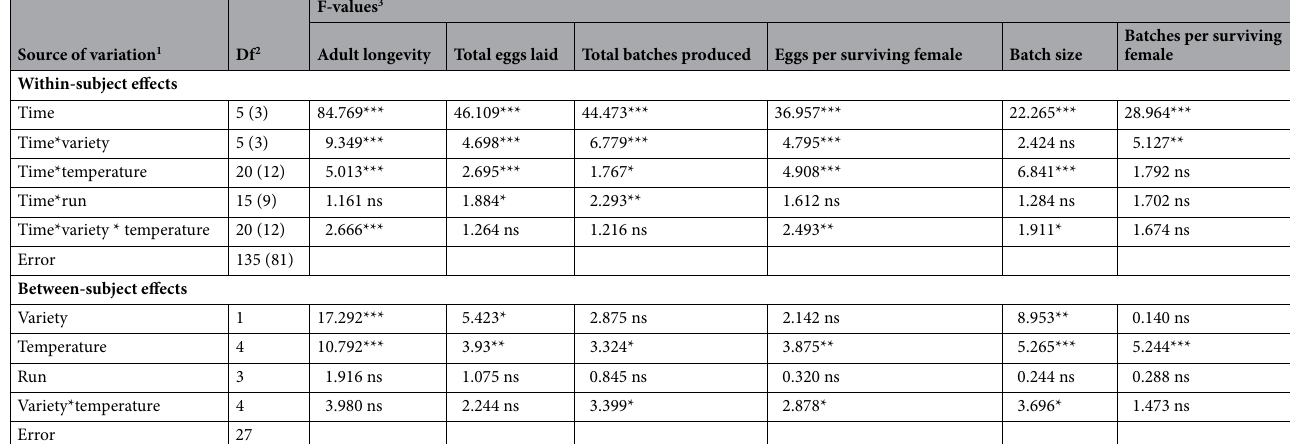
Table 1. F-values from repeated measures GLM for adult female longevity and oviposition parameters (see Fig. 1). 1 Time = time in days as experiment progresses; run = temporal replicate that includes observations for all temperatures conducted across different climate chambers. 2 Degrees of freedom in parentheses are for batches, eggs and batch size per female (i.e., last three columns). 3 ns = P > 0.05, * P ≤ 0.05, ** P ≤ 0.01, *** P ≤